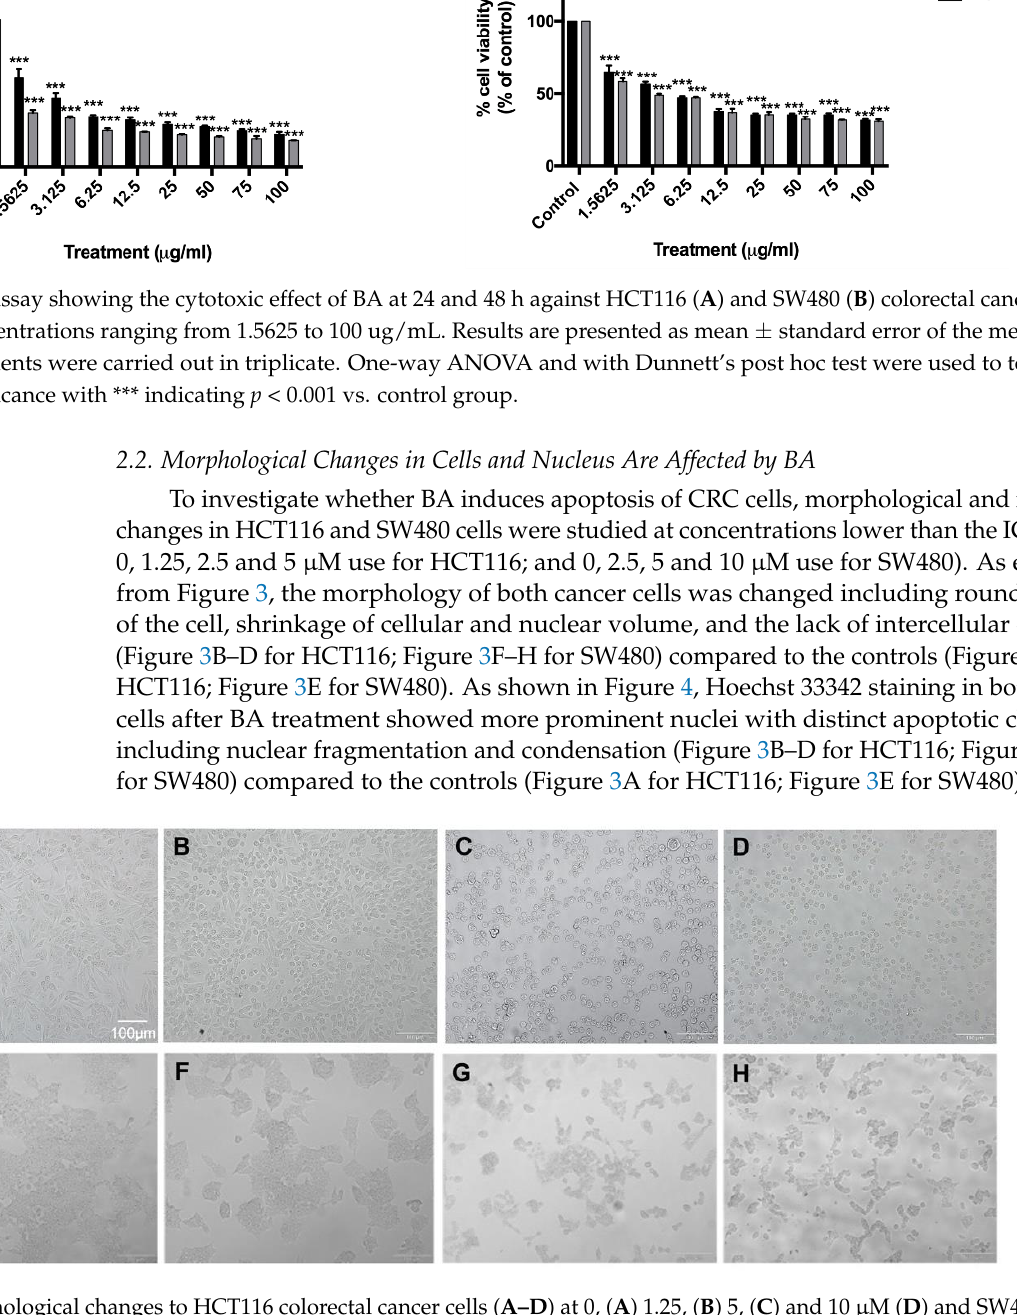
Figure 3. Morphological changes to HCT116 colorectal cancer cells ( A – D ) at 0, ( A ) 1.25, ( B ) 5, ( C ) and 10 µM ( D ) and SW480 colorectal cancer cells ( E – G ) at 0, ( E ) 2.3, ( F ) 5, ( G ) 10 ( H ) µM 24 h following the BA treatment.